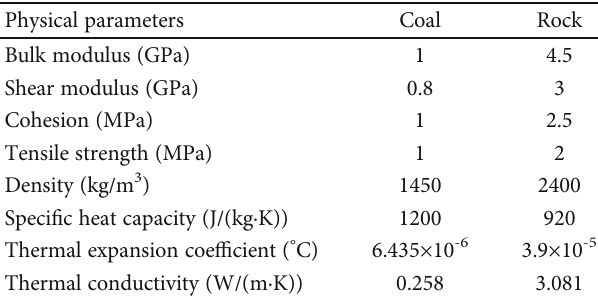
Table 1: Physical parameters of